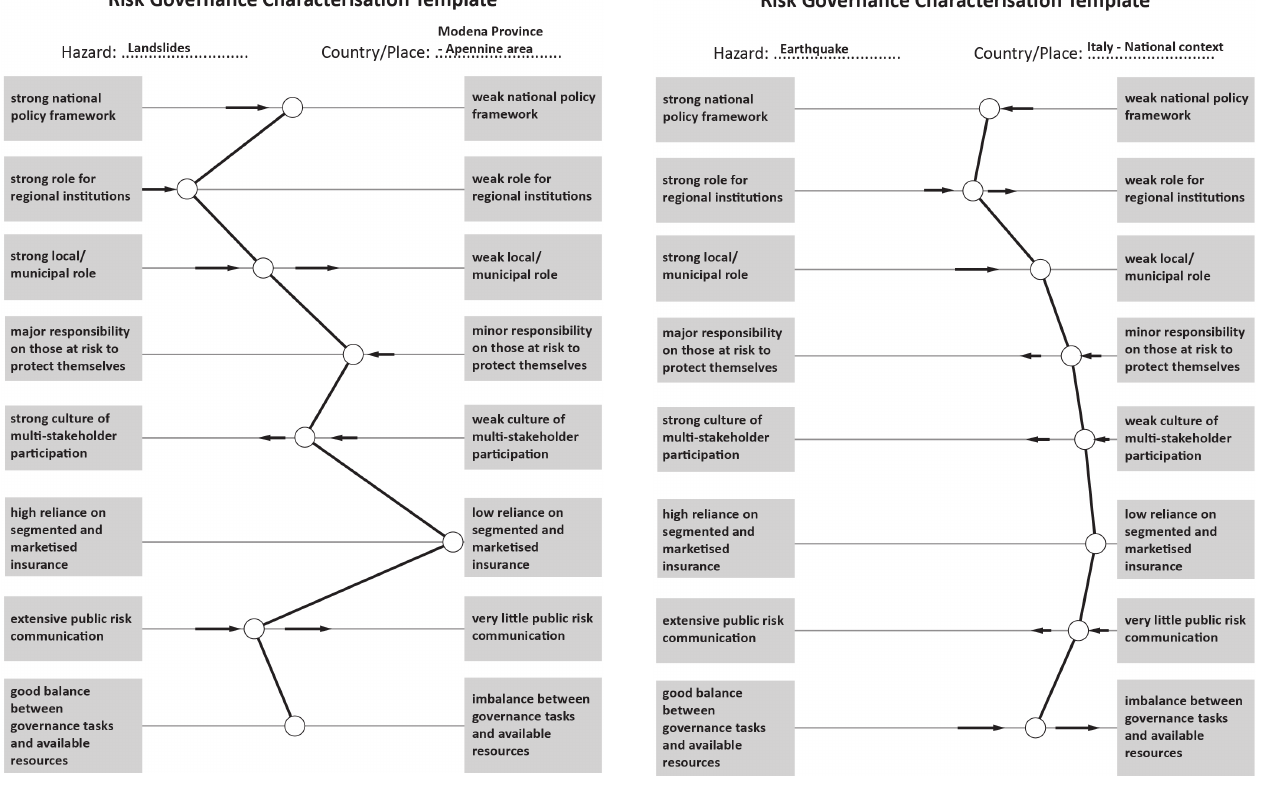
Fig. 4. Example of risk governance profile – Landslides in the Province of Modena, Italy.